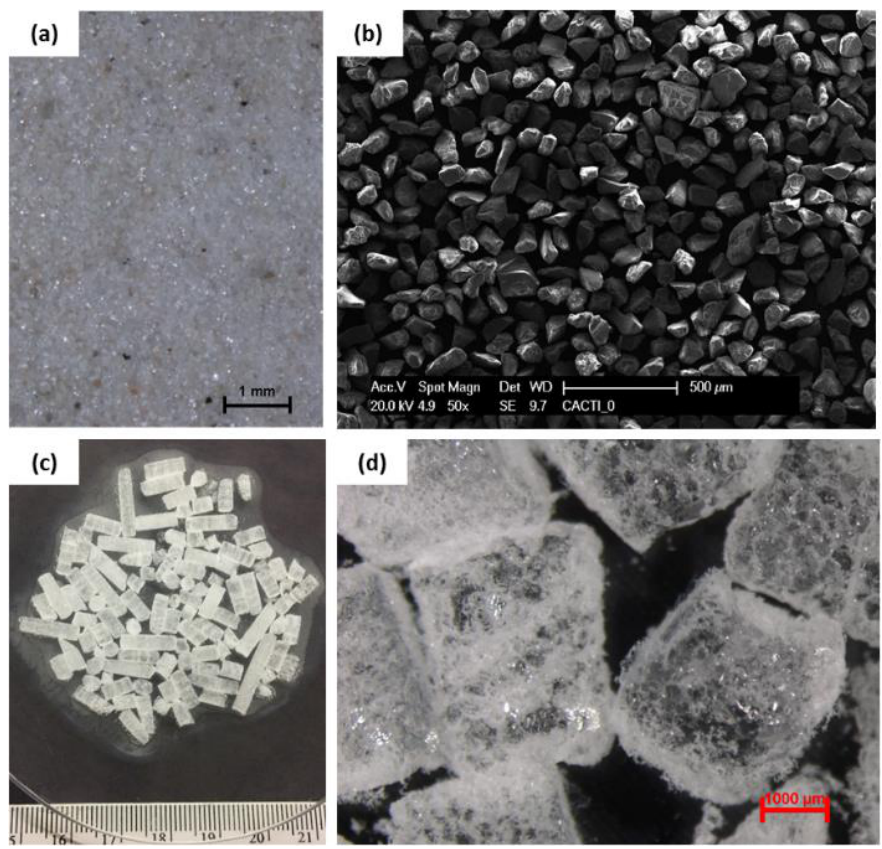
Figure 1. Abrasives used in the Hydrogommage and IBIX ( a , b ) and dry-ice cleaning ( c , d ) systems.